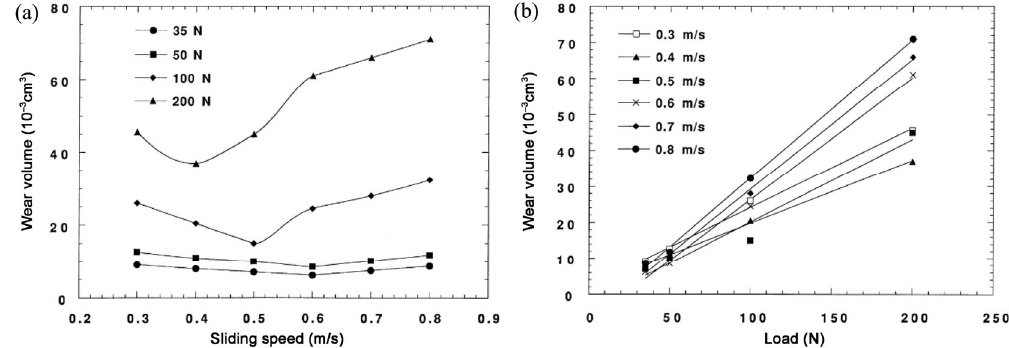
Fig. 24 Wear behavior of Ti64/Ti64 sliding pair: (a) variation in wear volume with increment in sliding speed; (b) variation in wear volume with increment in load. Reproduced with permission from Ref. [25]. Copyright Elsevier, 1997.